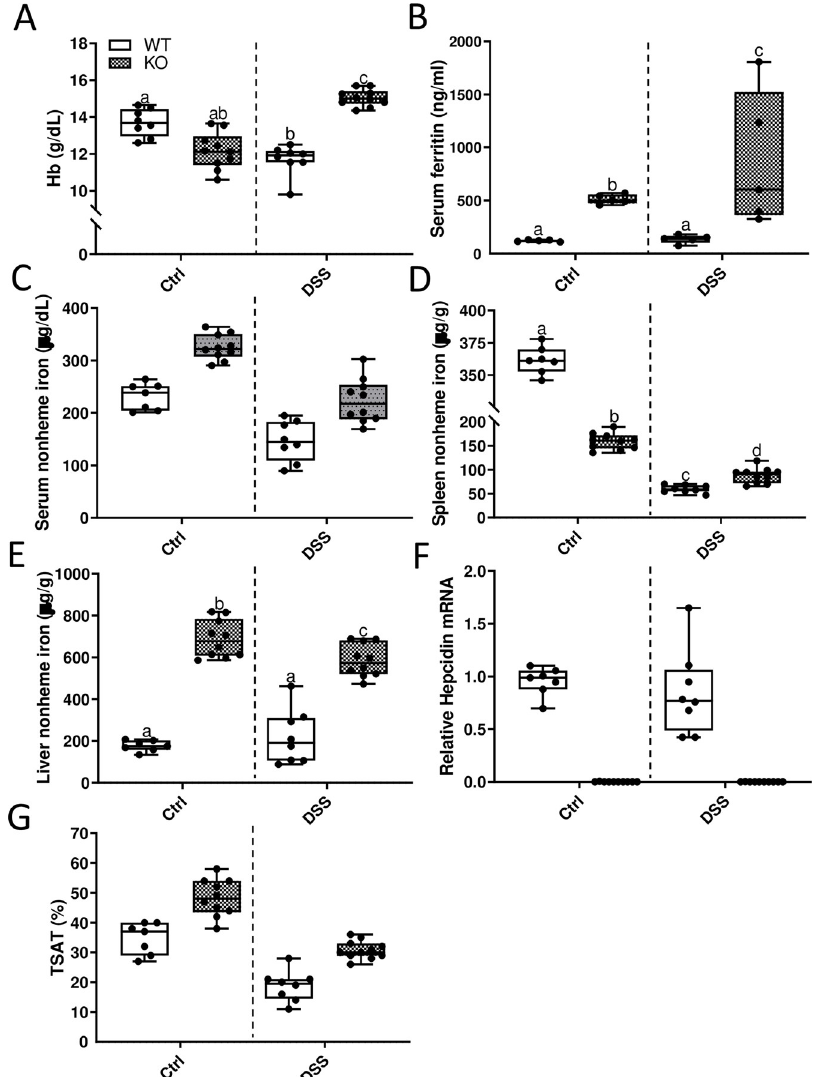
Fig 20. DSS treatment has differential effects on blood Hb levels and spleen and liver iron content in male WT versus Hamp KO rats. Hb levels were assessed in 10-week-old control and DSS-treated male WT and Hamp -/- rats ( A ). Serum ferritin levels were also determined ( B ). Serum ( C ), spleen ( D ) and liver ( E ) nonheme iron content was also assessed. Liver hepcidin mRNA expression was determined by qRT-PCR ( F ). TSAT was also assessed post- mortem ( G ). Data are presented as box plots for two independent experiments with n = 8–10 rats/group and were analyzed by two-way ANOVA with Tukey’s multiple comparisons post-hoc test. Groups without common letters differ significantly ( p � 0.0101). Genotype × Treatment, p � 0.0001 ( A, B, D, E ); Genotype p � 0.0014 ( A-E, G ); Treatment, p � 0.0001 ( C, D, G